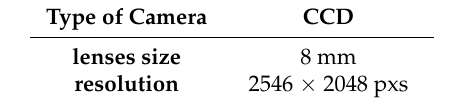
Table 4. Camera features.